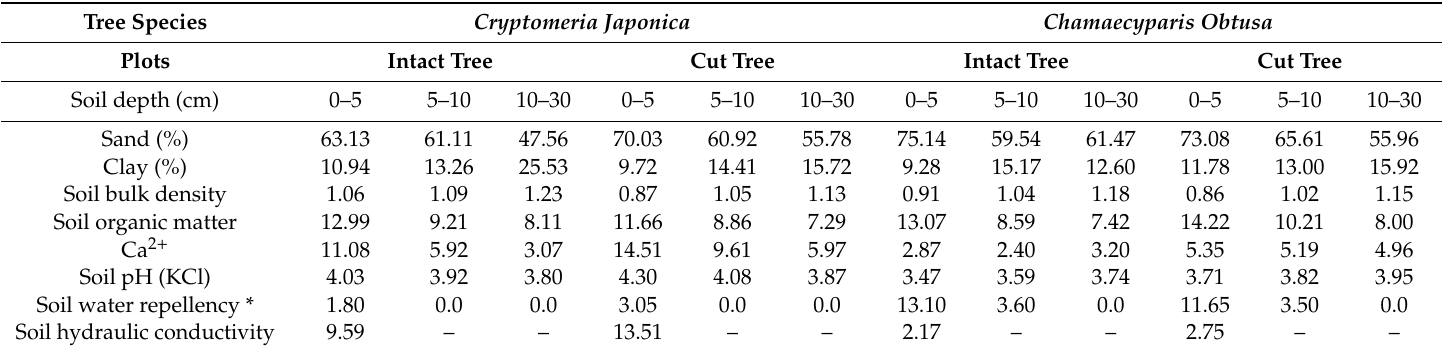
Table 1. Soil properties in the studied